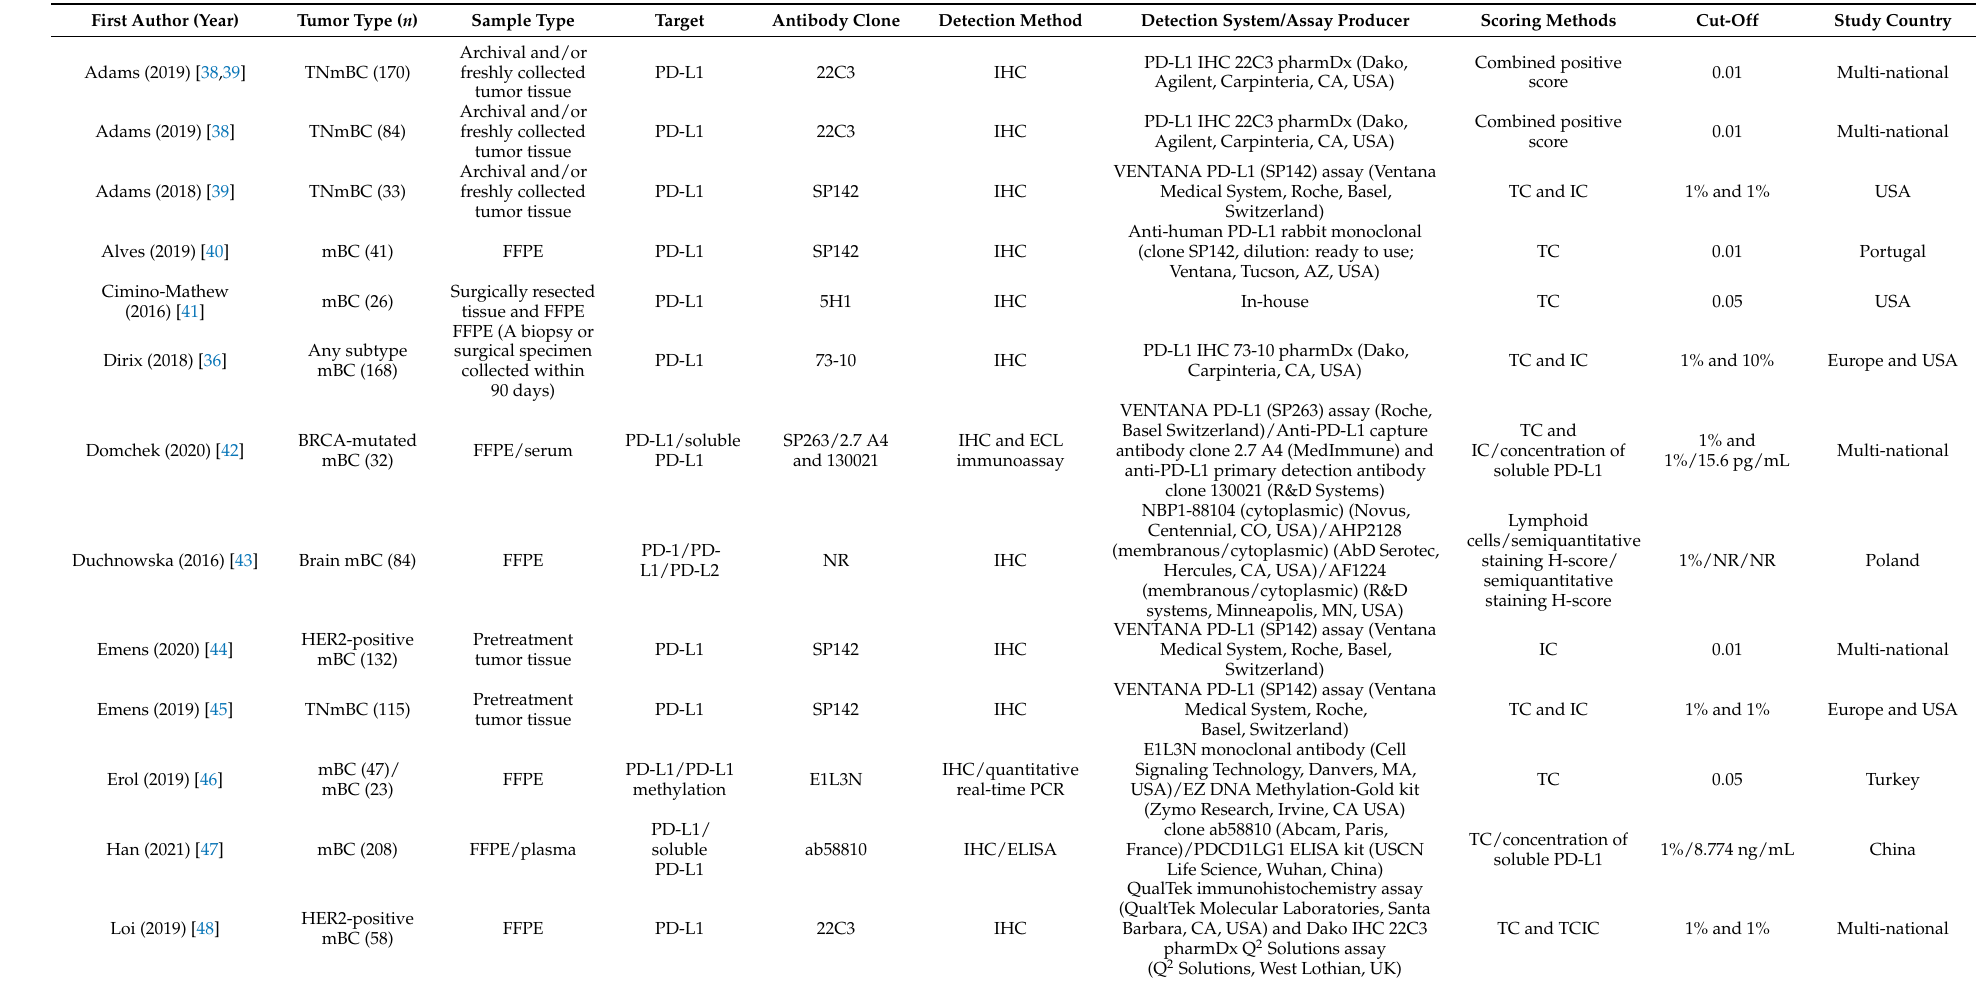
Table 1. Main characteristics and immunological assays of studies for PD-1, PD-L1, and PD-L2 in metastatic breast